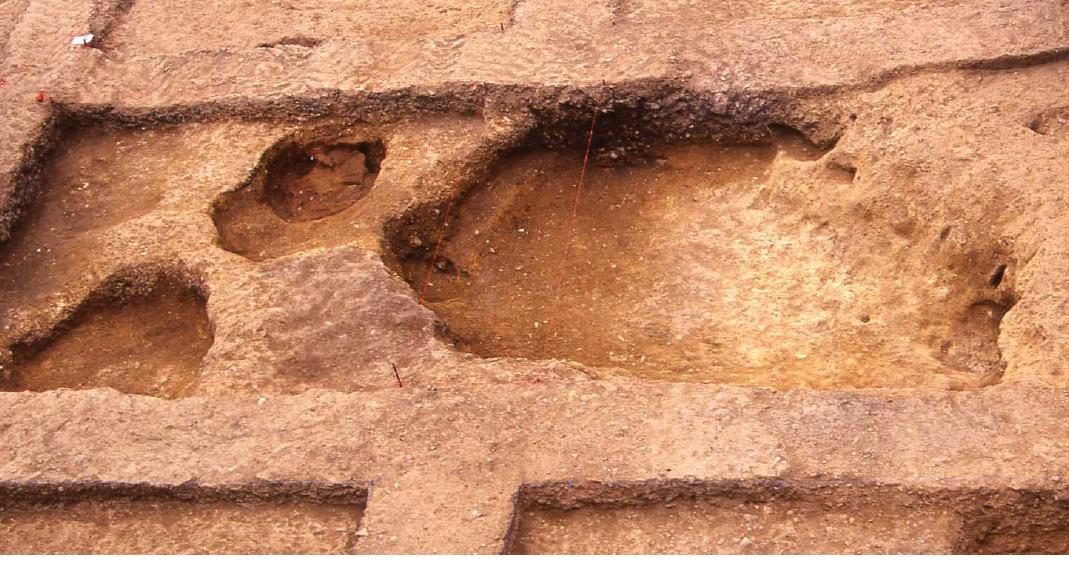
Figure 4. Stavroupoli. Pit dwelling of the phase Stavroupoli Ia (Kotsos